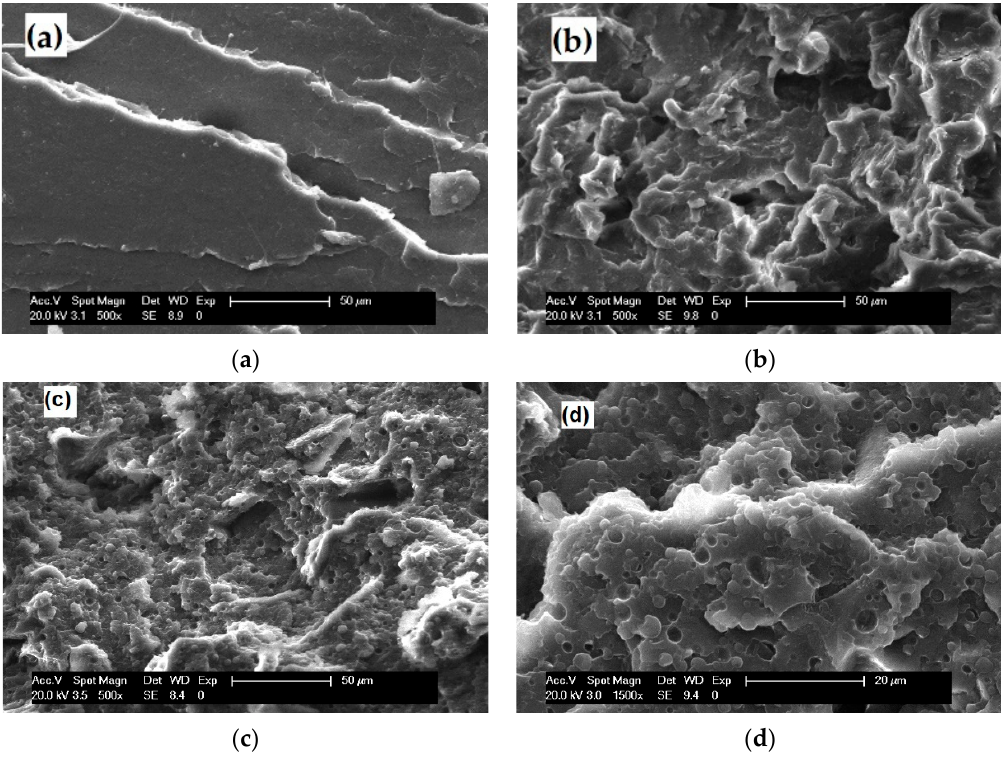
Figure 4. Fracture surface of PLA ( a ), PLA-CSS ( b ), PLA_CSS_T ( c ), and PLA_CSS_T ( d ) at higher magnification.